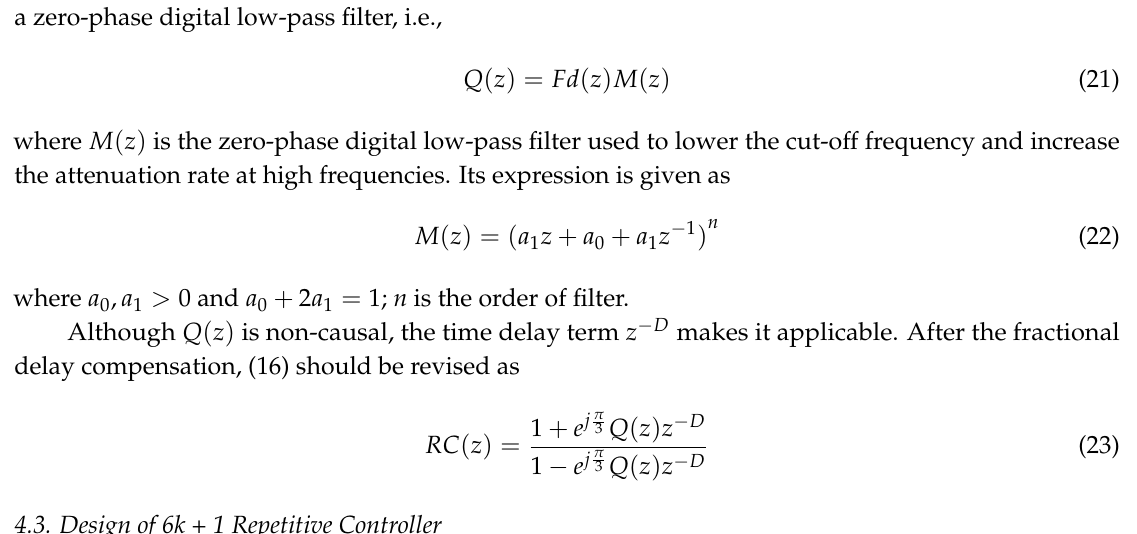
Figure 5. Bode plot of Fd(z).